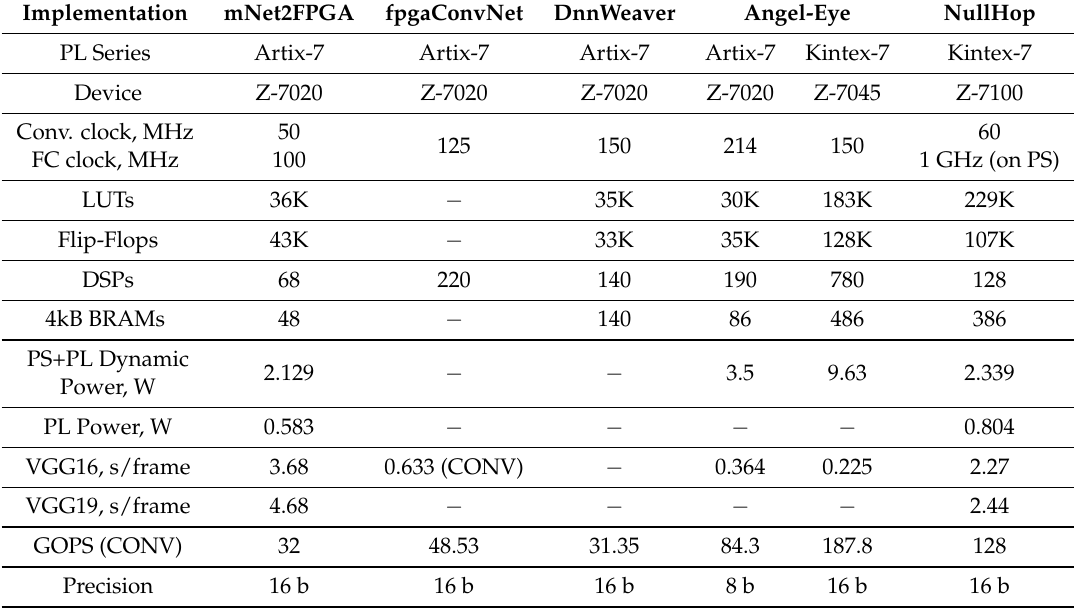
Table 5. Comparison to a fpgaConvNet [13], DnnWeaver [18], Angel-Eye [17] and NullHop [21]